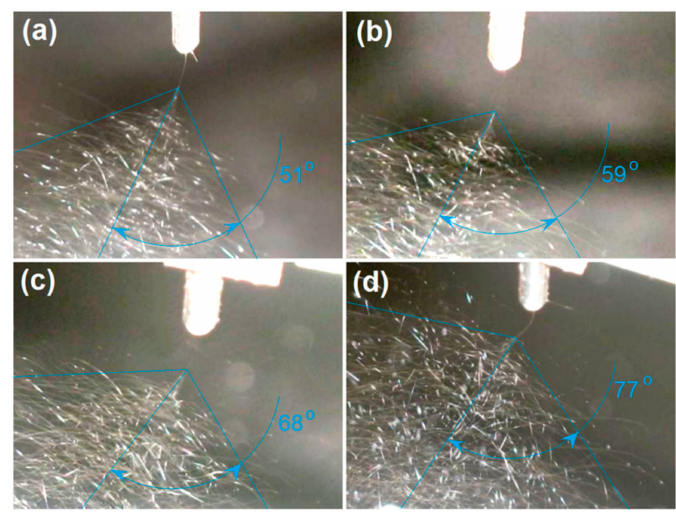
Figure 4. The changes of spreading angle and the length of straight fluid jet with the increase of LiCl in the sheath solution (mg / mL): ( a ) 0; ( b ) 5; ( c ) 10; ( d ) 20.